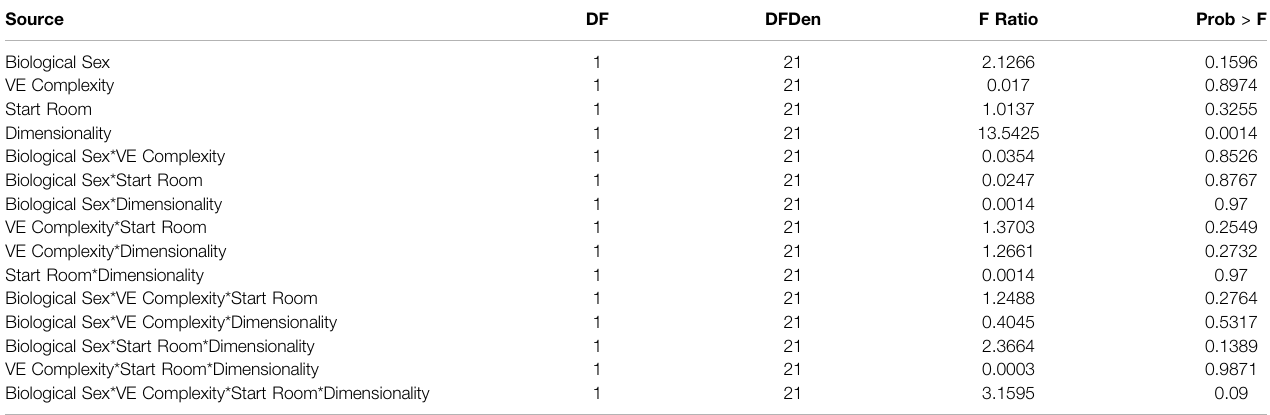
TABLE 2 | IMRT score fi xed effect tests.